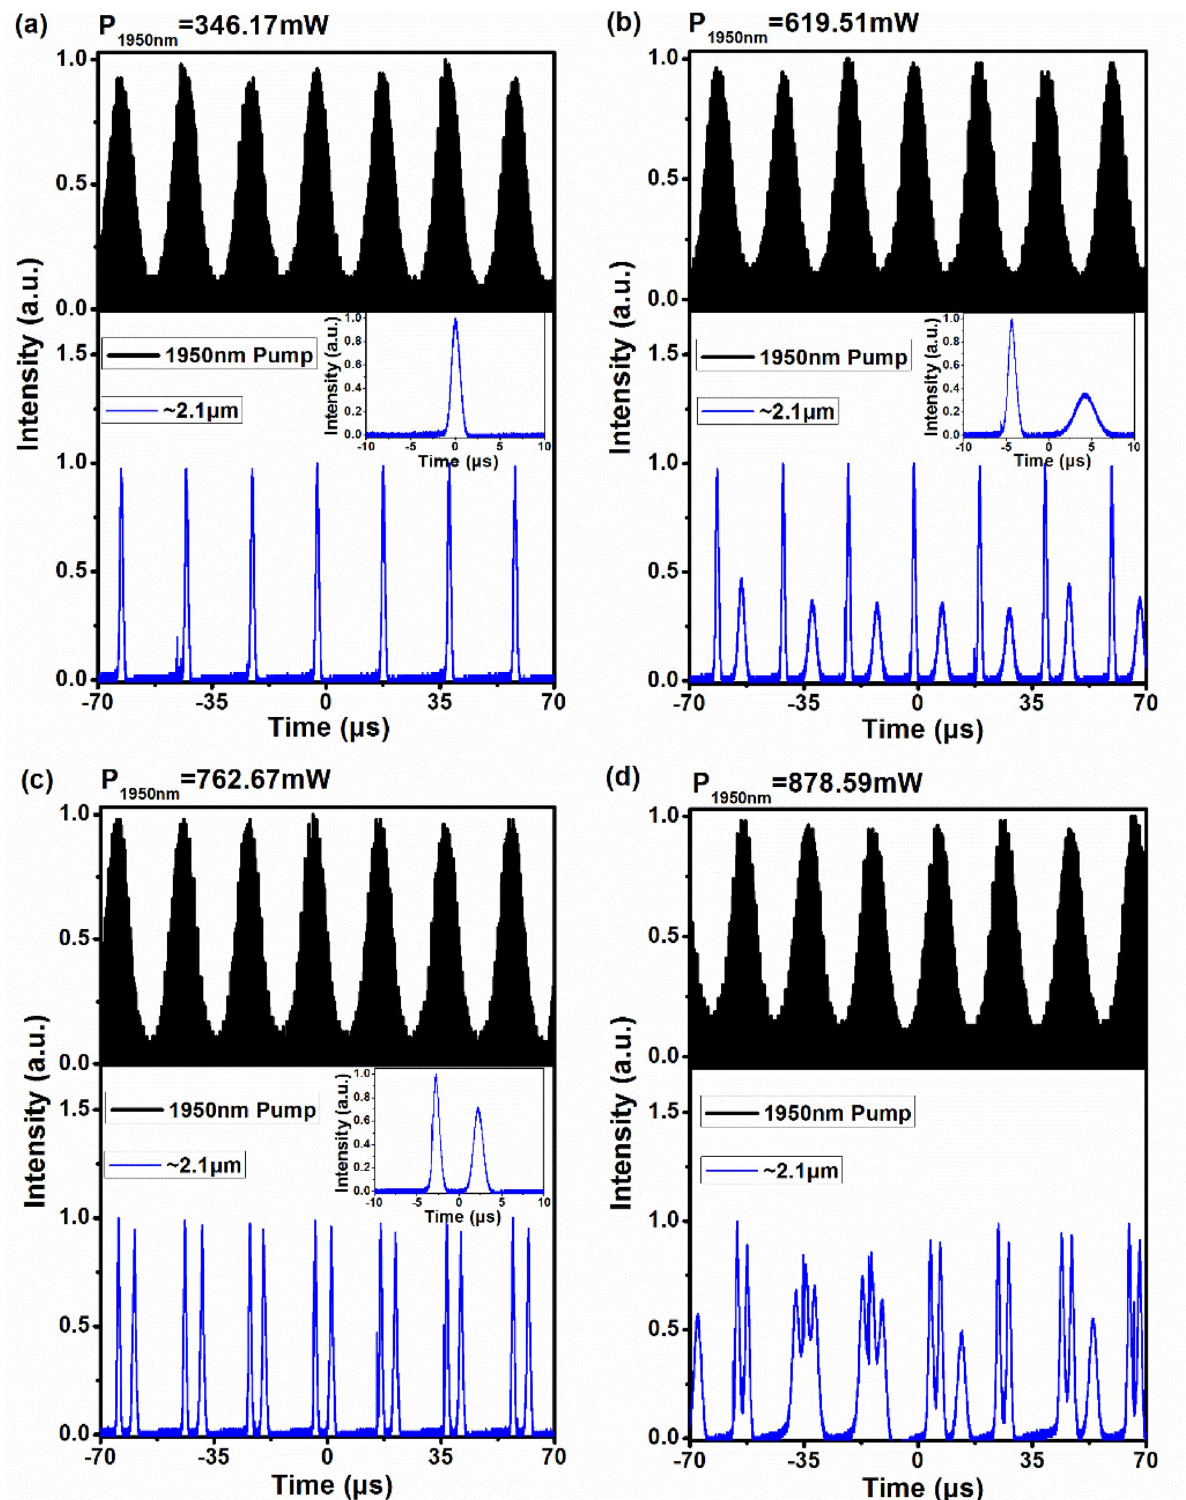
Figure 1. Temporal pulse trains and pulse profile (inset) of the ~ 2.1 μm gain-switching at the 1950 nm pump power of ( a ) 346.17 mW and ( b ) 619.51 mW; ( c ) 762.67 mW, ( d ) 878.59 mW without the 1150 nm CW pump